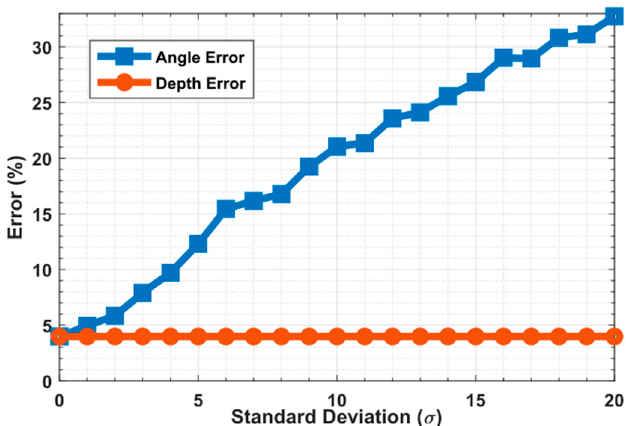
Figure 13. The classification error trend when the angle of transmission and depth are subjected to an additive gaussian error with zero mean and standard deviation depicted on the x -axis.